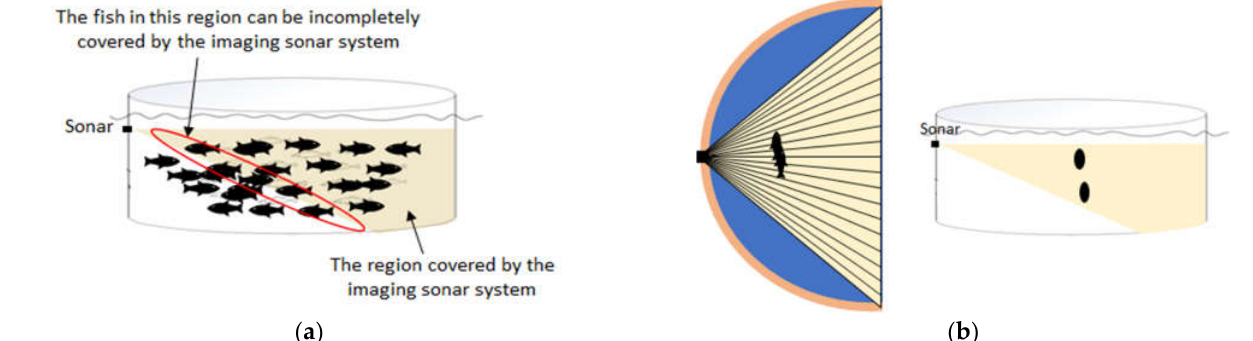
Figure 3. An illustration of the region covered by an imaging sonar system where ( a ) shows that the imaging sonar system can partly cover the fish, and ( b ) shows that the fish at different locations in the direction perpendicular to the sonar beam can be overlapped in the sonar image.